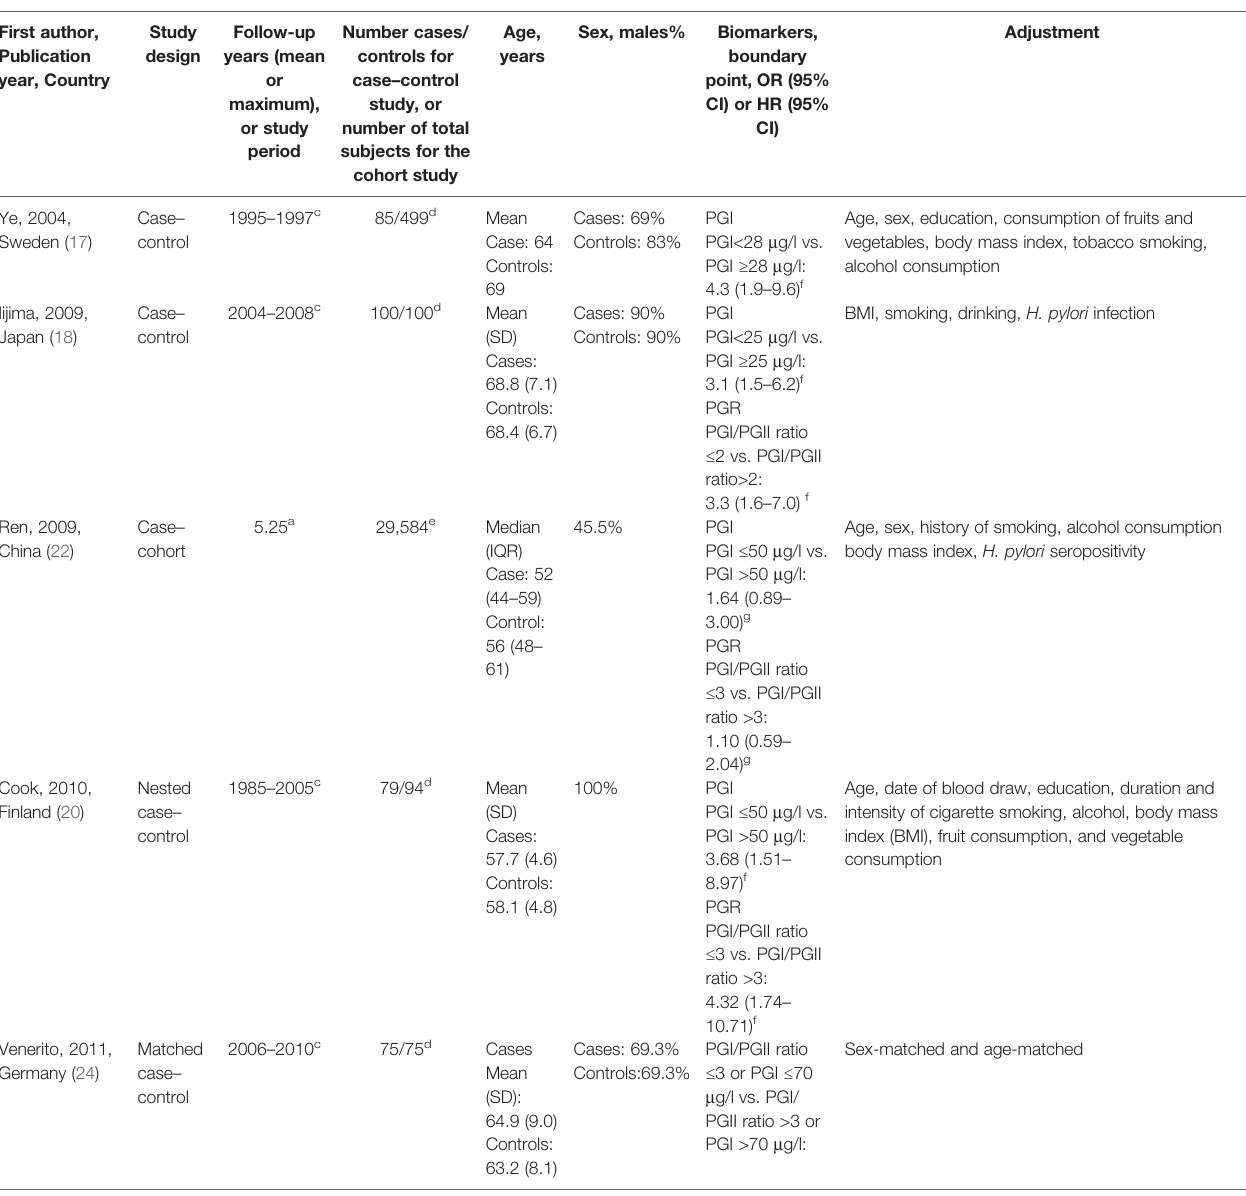
TABLE 1 | Characteristics of the included